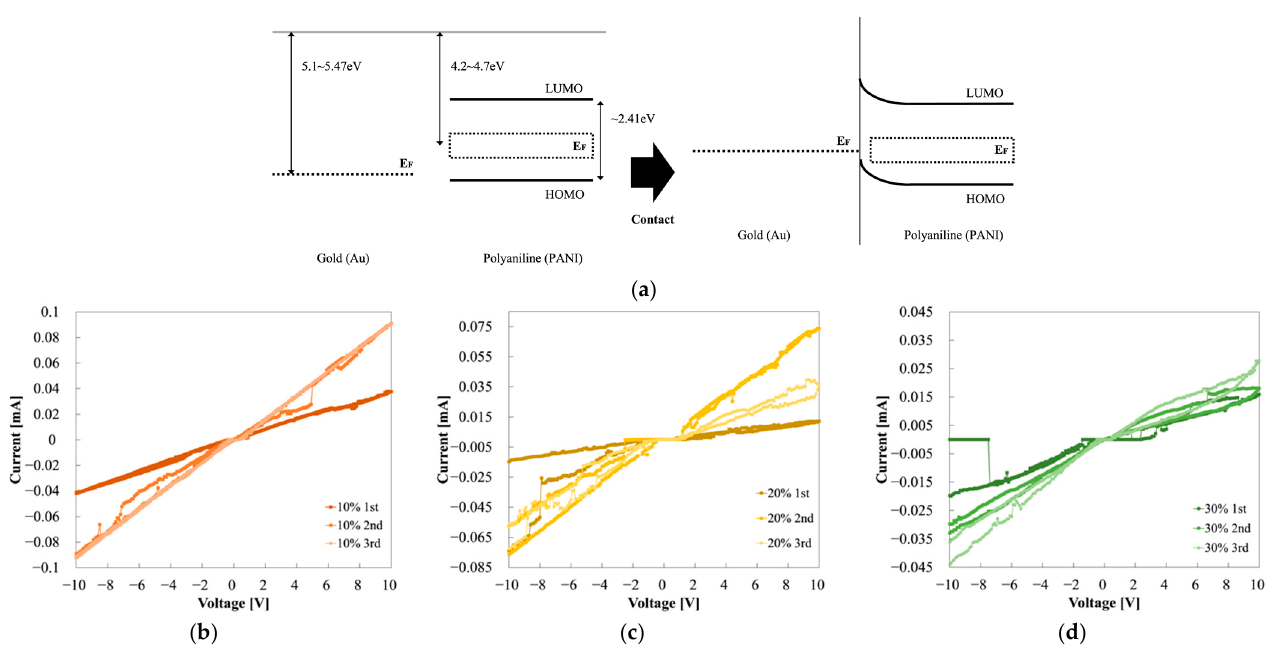
Figure 11. ( a ) Energy band diagram of PANI and the MCL before contact ( left ) and after contact ( right ); the individual I − V curves according to strain in Sample B: ( b ) 10% of strain, ( c ) 20% of strain, and ( d ) 30% of strain.